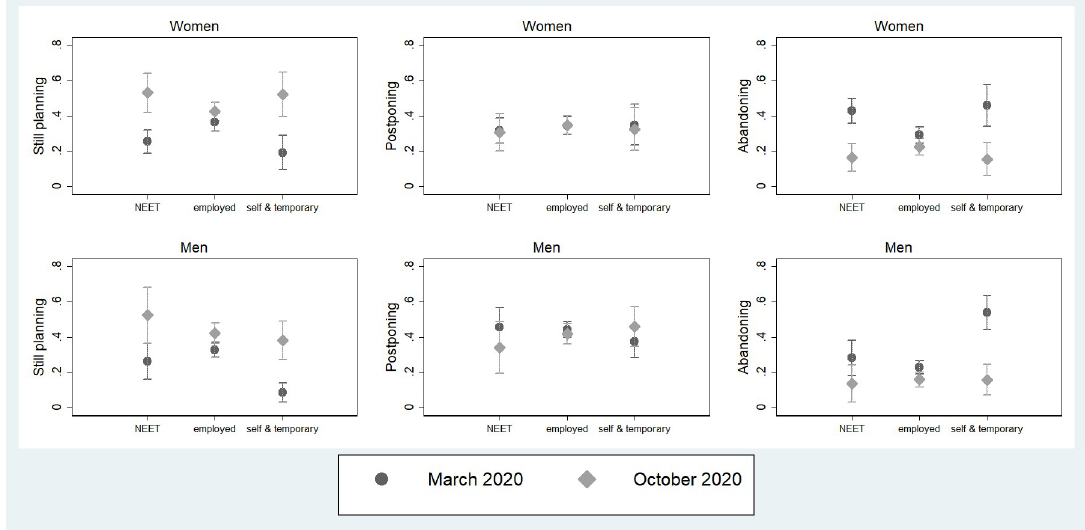
Fig 2. Predicted probabilities of changes or confirmations of pre-COVID fertility plans in March and October 2020 across occupational conditions (confidence intervals for pair-wise comparisons at the 10% significance level). Note: Predicted probabilities bases on a multinomial logit model, controlling for age class, education, marital status, presence of children. Full results are available in S1_4 and S1_5 Tables in S1 Appendix. Confidence intervals are calculated to allow for multiple comparisons of predicted probabilities, i.e., to allow testing their statistical equality at an approximate 5% significance level. Overlap between a pair of intervals indicate that the corresponding predicted probabilities are not statistically different at the 10% level, while non-overlap indicate a significant difference.